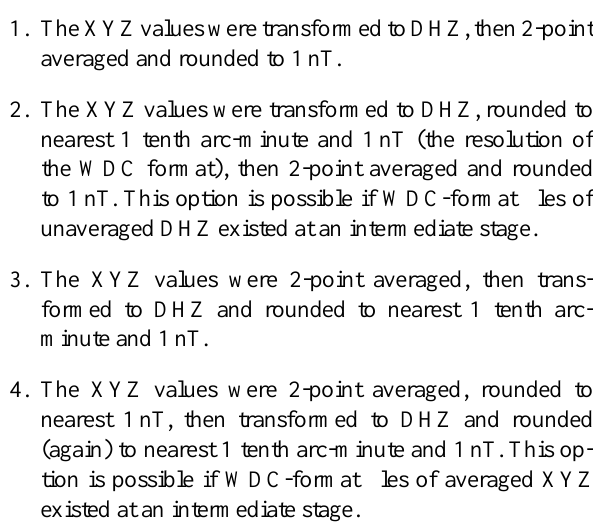
analyses of IHV indices for inferring long-term changes